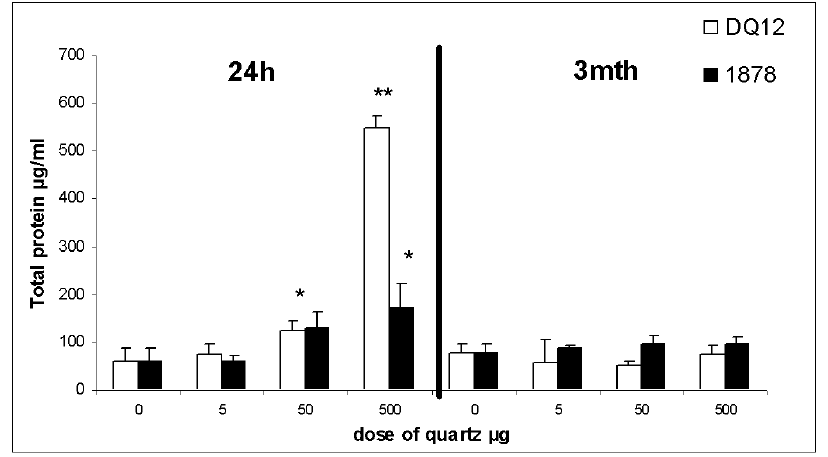
FIGURE 6. Quartz - total protein in BALF. The levels of total protein in BALF are shown as the median and 75 th percentile for DQ12 .(white) and SRM1878a (black). BALF was collected 24 h or 3 months postinstillation in BALB/c mice. For explanation of statistical test results (* and **), see Statistics. Each group contained eight